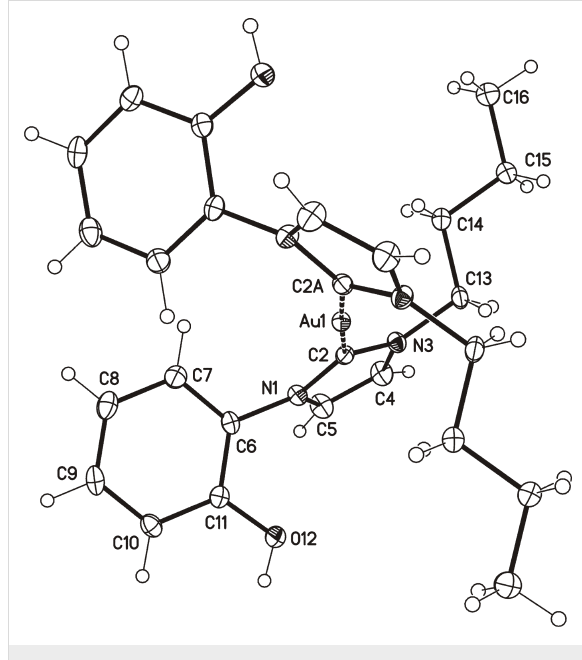
Figure 3: Molecular drawing of the cation of the gold complex 9 (dis- placement parameters are drawn at 50% probability level; crystallo- graphic